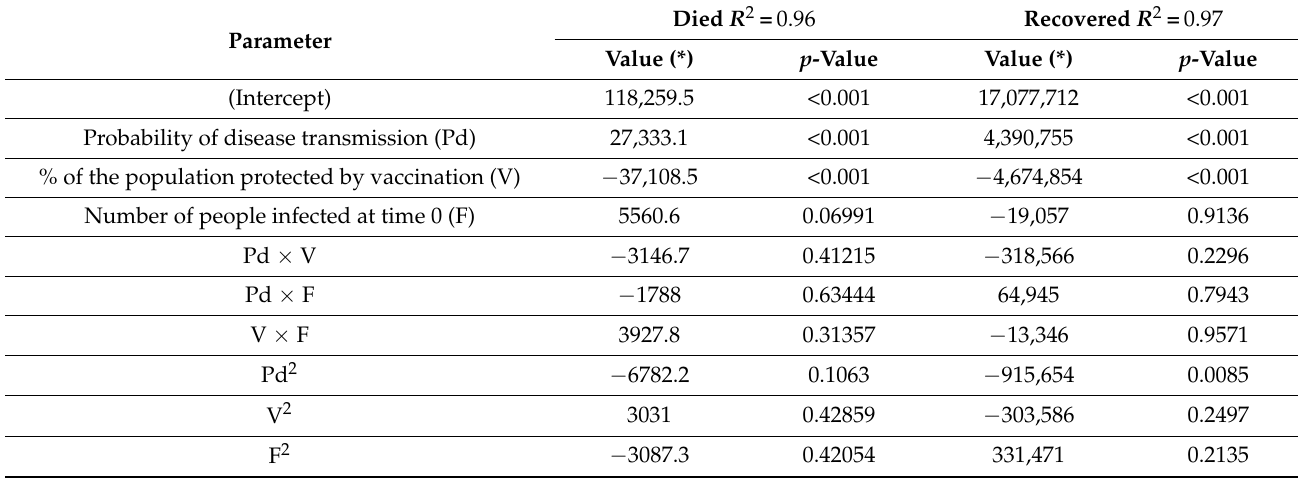
Table 1. Box–Behnken estimated values of the response surface parameters. Disease control measures, and vaccine and protection measures.